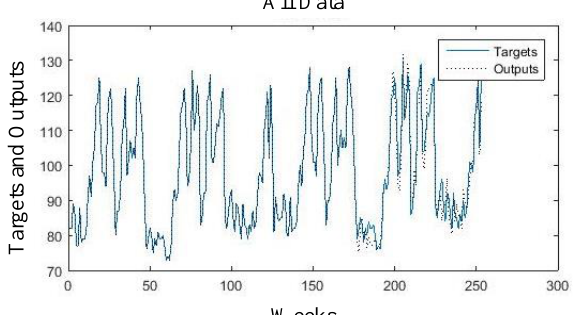
Fig. 13. Comparison of targets and outputs for RBFNN model.